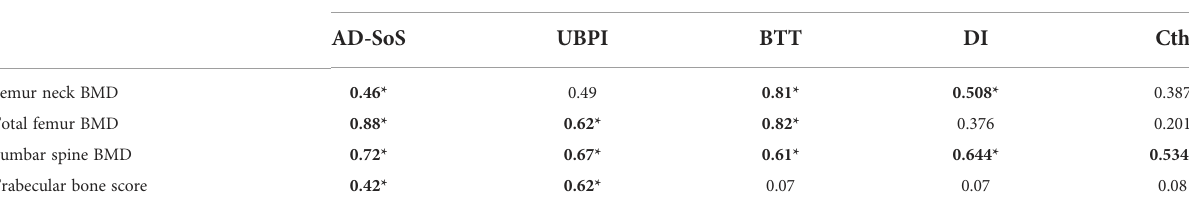
with DXA-derived TBS at the lumbar spine ( r = 0.71, p < 0.001) and with AD-SoS values ( r = 0.369, p = 0.023). No signi fi cant associations were observed between handgrip strength and metabolic parameters ( p for all > 0.05) in patients and controls. TABLE 2 Coef fi cients of association ( r ) between DXA and ultrasound measurements in hemodialysis patients.